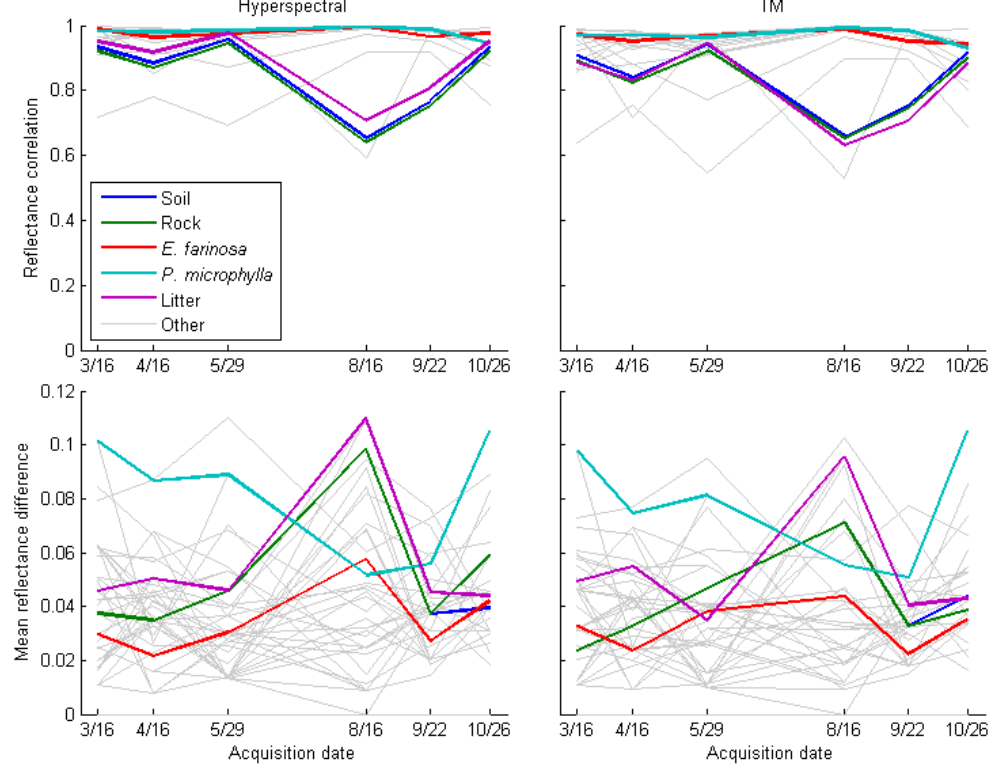
Figure 5. Correlation of reflectances (top row) and mean reflectance differences (bottom row) between P. ciliare and native cover types for full spectra (left column) and TM-convolved spectra (right column) for six dates in 2007. Five most abundant cover types are denoted by thick colored lines, whereas less abundant cover types are denoted by light grey.